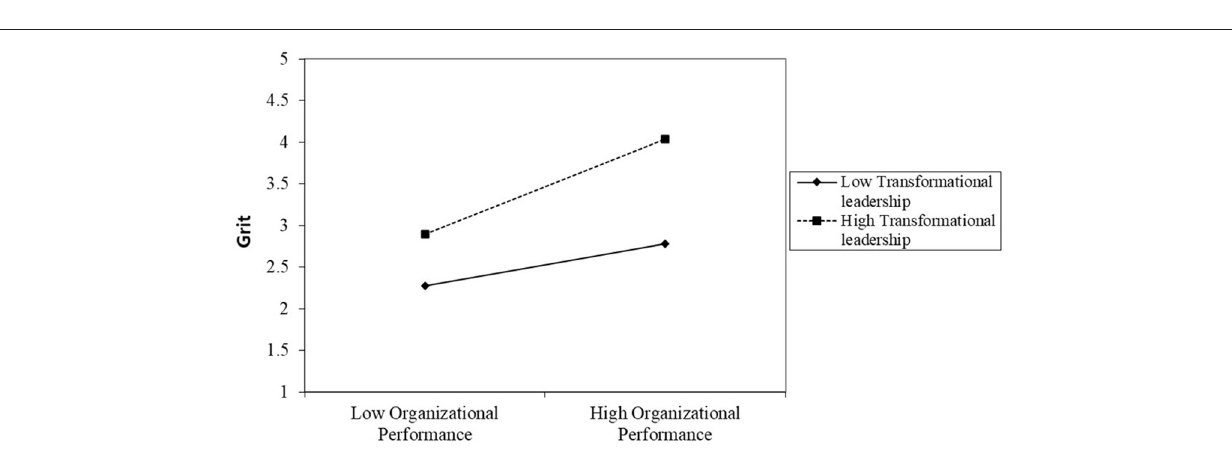
FIGURE 4 | Moderating effect of transformational leadership on the relationship between grit and organizational